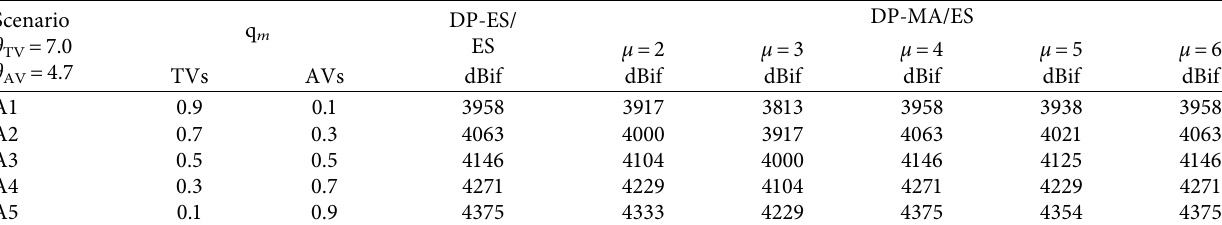
Table 4: Bifurcation demand flow, AVs scenarios A θ